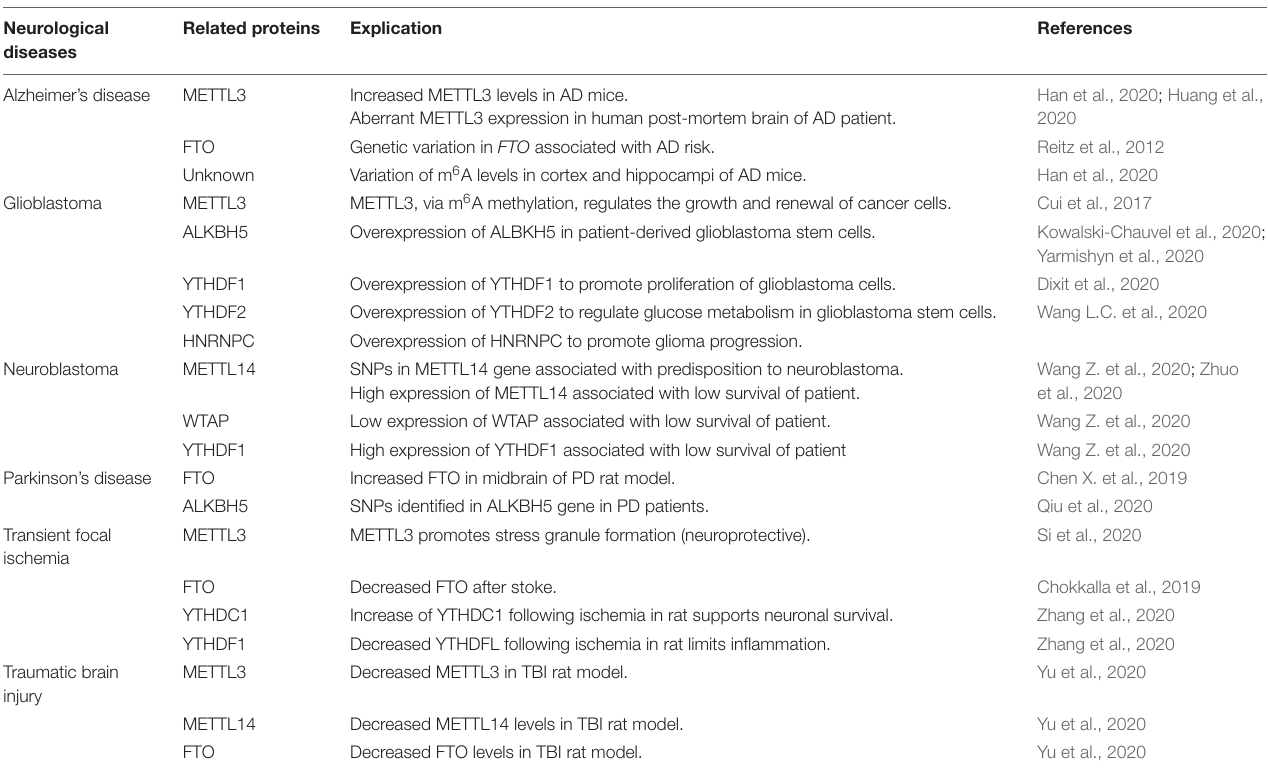
TABLE 2 | m 6 A machinery proteins in neurological